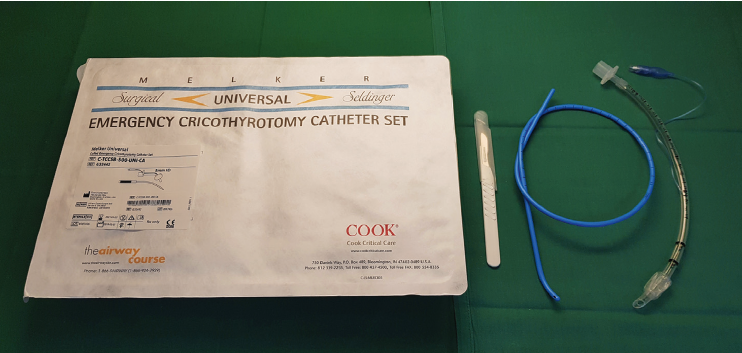
Figure 5: Drawer 4 (plan D) front-of-neck access (FONA). Note that the Frova introducer is not included in the drawer but attached to the side of the